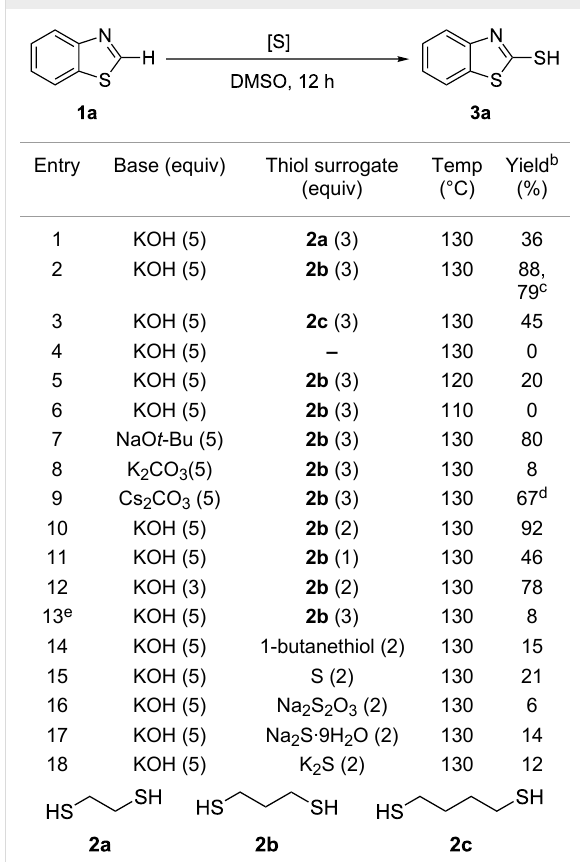
Table 1: Screening of the conditions for C–H mercaptalization of benzothiazole.